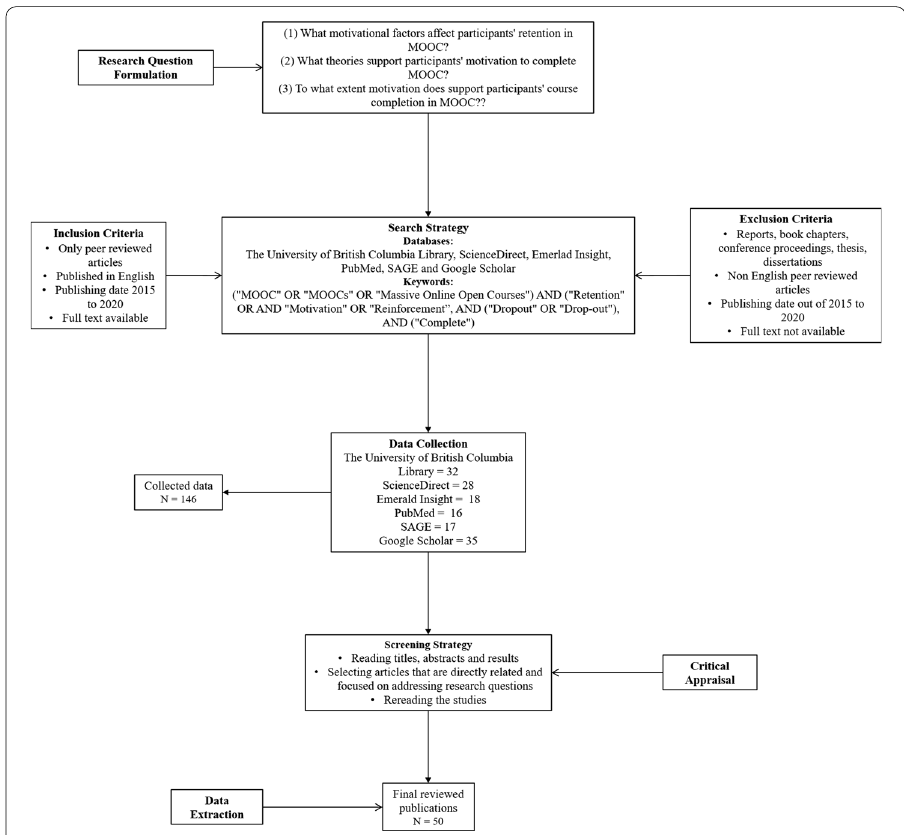
Fig. 1 Flow diagram of the systematic literature review